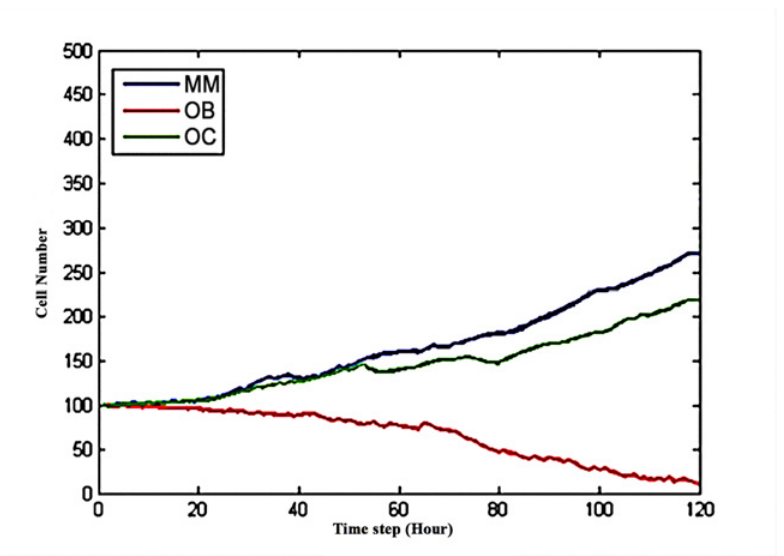
Fig 6. The effect of BHQ880 on the number of OBs, OCs and